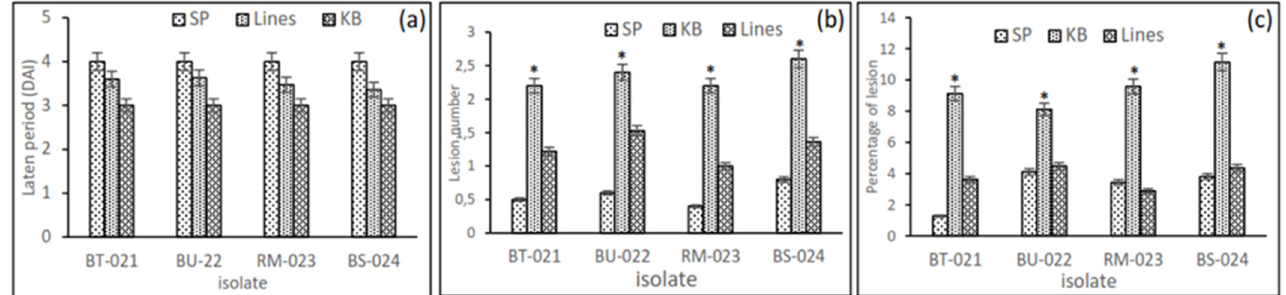
Figure 2. Screening for blast resistance in an inbred upland rice line using four isolates, BT-021, BU-022, RM-023, and BS-024, under greenhouse conditions: ( a ) the latent period, namely the time until lesions first appeared in the tested lines and the SP-resistant and KB-susceptible control varieties; ( b ) the number of leaf lesions on the tested lines and the SP-resistant and KB-susceptible control varieties. “*” indicate statistical significance by two-tailed Student’s t -tests ( p < 0.05); ( c ) percentage of lesions appearing on leaves counted in one clump